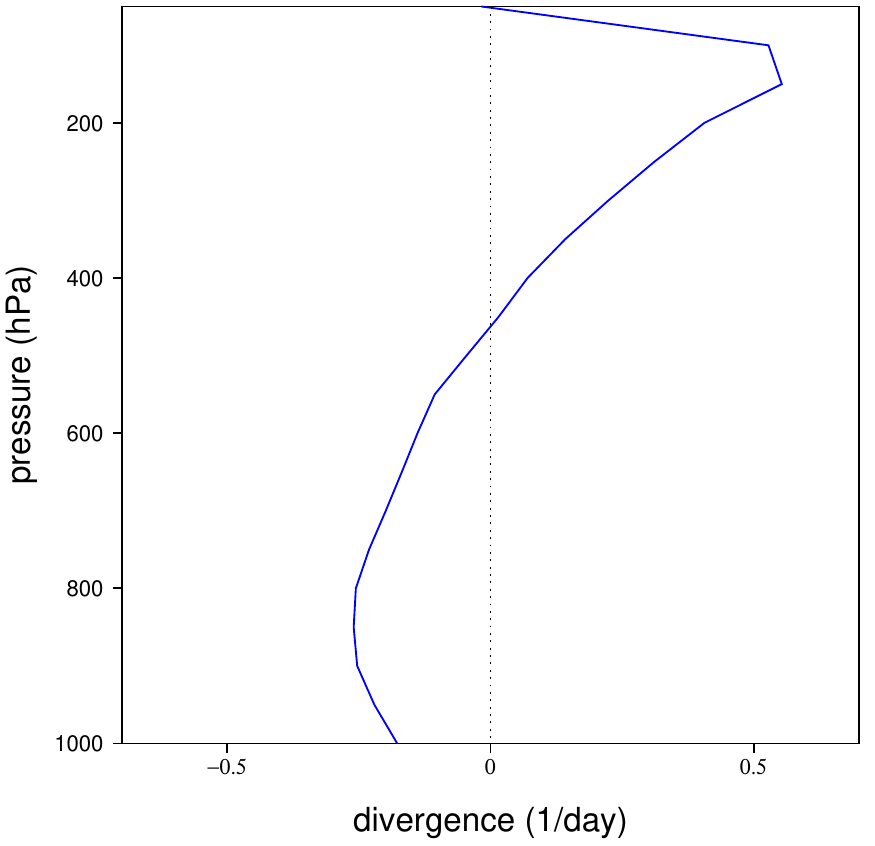
Figure 1. The average horizontal divergence perturbation within 10 degrees longitude and 5 degrees latitude of the MJO’s convective center during the mature stage. This function defines the vertical structure of the deep convective